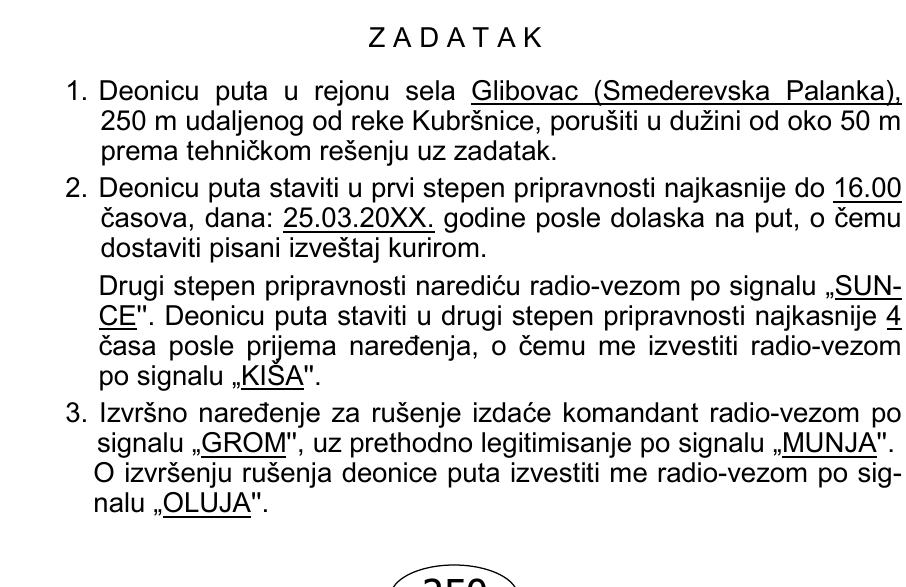
Osnovni problem koji se ovde name ć e jeste č injenica da trenutno ne postoji literatura novijeg datuma, odnosno savremena norma za rušenje deonice puta, kao i da se postoje ć a norma odnosi na organizacijsko-for- macijsku strukturu i mogu ć nosti pionirske č ete iz vremena tadašnje JNA, što predstavlja enormnu razliku u pogledu strukture i mogu ć nosti pionir- ske č ete VS. Radi prevazilaženja navedenog problema i dostizanja mogu ć nosti ispunjenja postoje ć ih normi, neophodno je izvršiti: promenu materijalne strukture pionirske č ete VS i promeniti zadatke, a samim tim i standard obu č enosti pripadnika jedinice i same jedinice – kroz izmenu postoje ć ih standarda, ali i kroz individualnu i kolektivnu evaluaciju. U nastavku rada navodi se primer zadatka plana rušenja, specifika- cije potrebnih PS (tabela 1) i dela organizacije inžinjerijskih radova pri rušenju deonice puta (tabela 2). (Hristov,